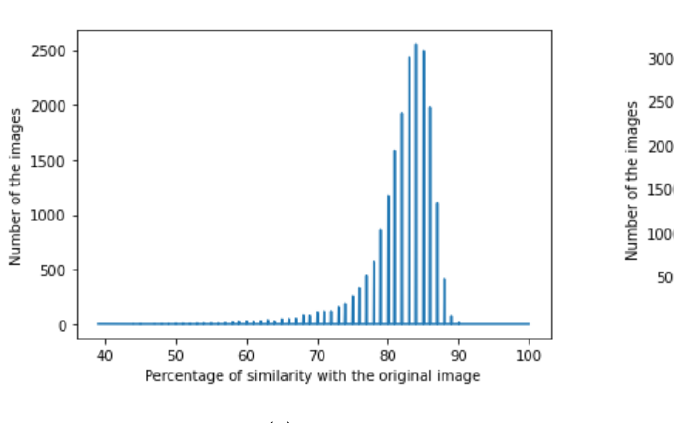
Figure 8. The histogram of similarity between the predicted denoised image and the original image in the case of Poisson noise: ( a ) one autoencoder with separable convolutional neural networks; ( b ) dual autoencoder with separable convolutional neural networks.